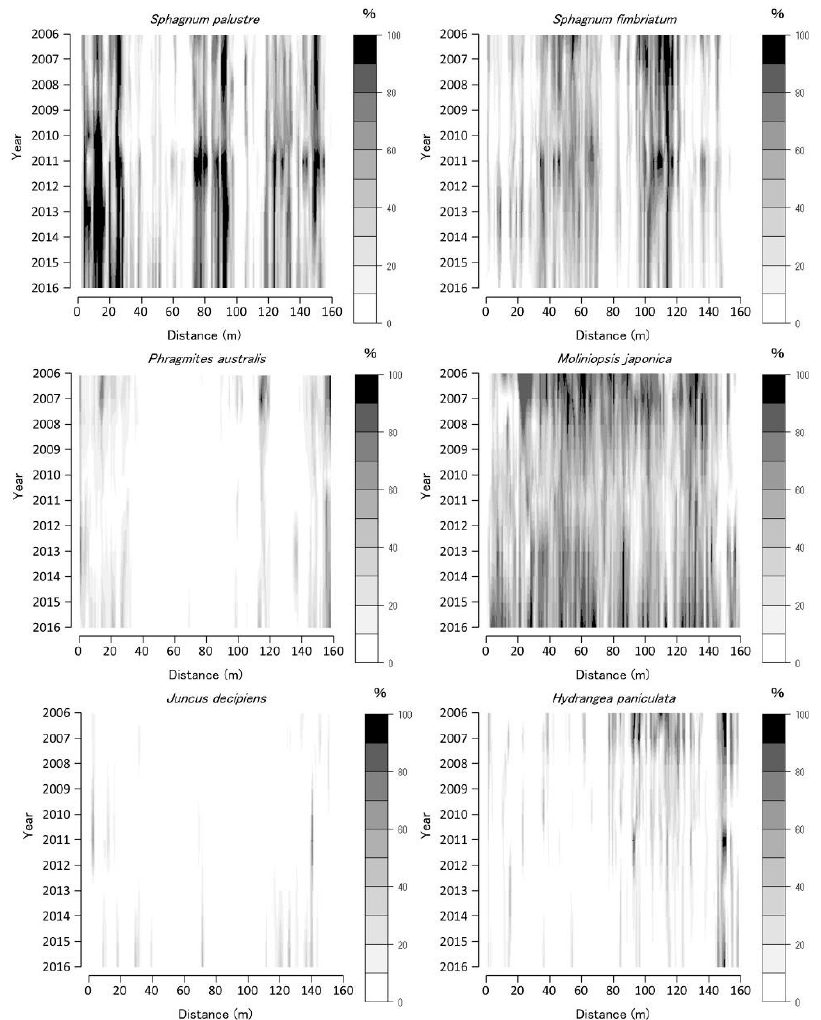
Figure 3. Coverage of Sphagnum palustre , Sphagnum fimbriatum , Phragmites australis , Moliniopsis japonica , Juncus decipiens , and Hydrangea paniculata along the Tadewara transect (TDW transect). Data were collected at every 1 × 1 m 2 quadrat placed sequentially on the transect. Countered figures of coverage on the axes of year and position were drawn by interpolating data collected in 2006, 2007, 2008, 2010, 2011, 2013, and 2016.